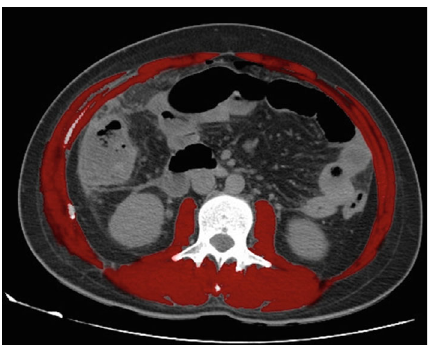
Figure 1: Evaluation of the skeletal muscle mass using a third lumbar computed tomography scan slice. Red: skeletal muscle (including the psoas, paraspinal, and abdominal wall